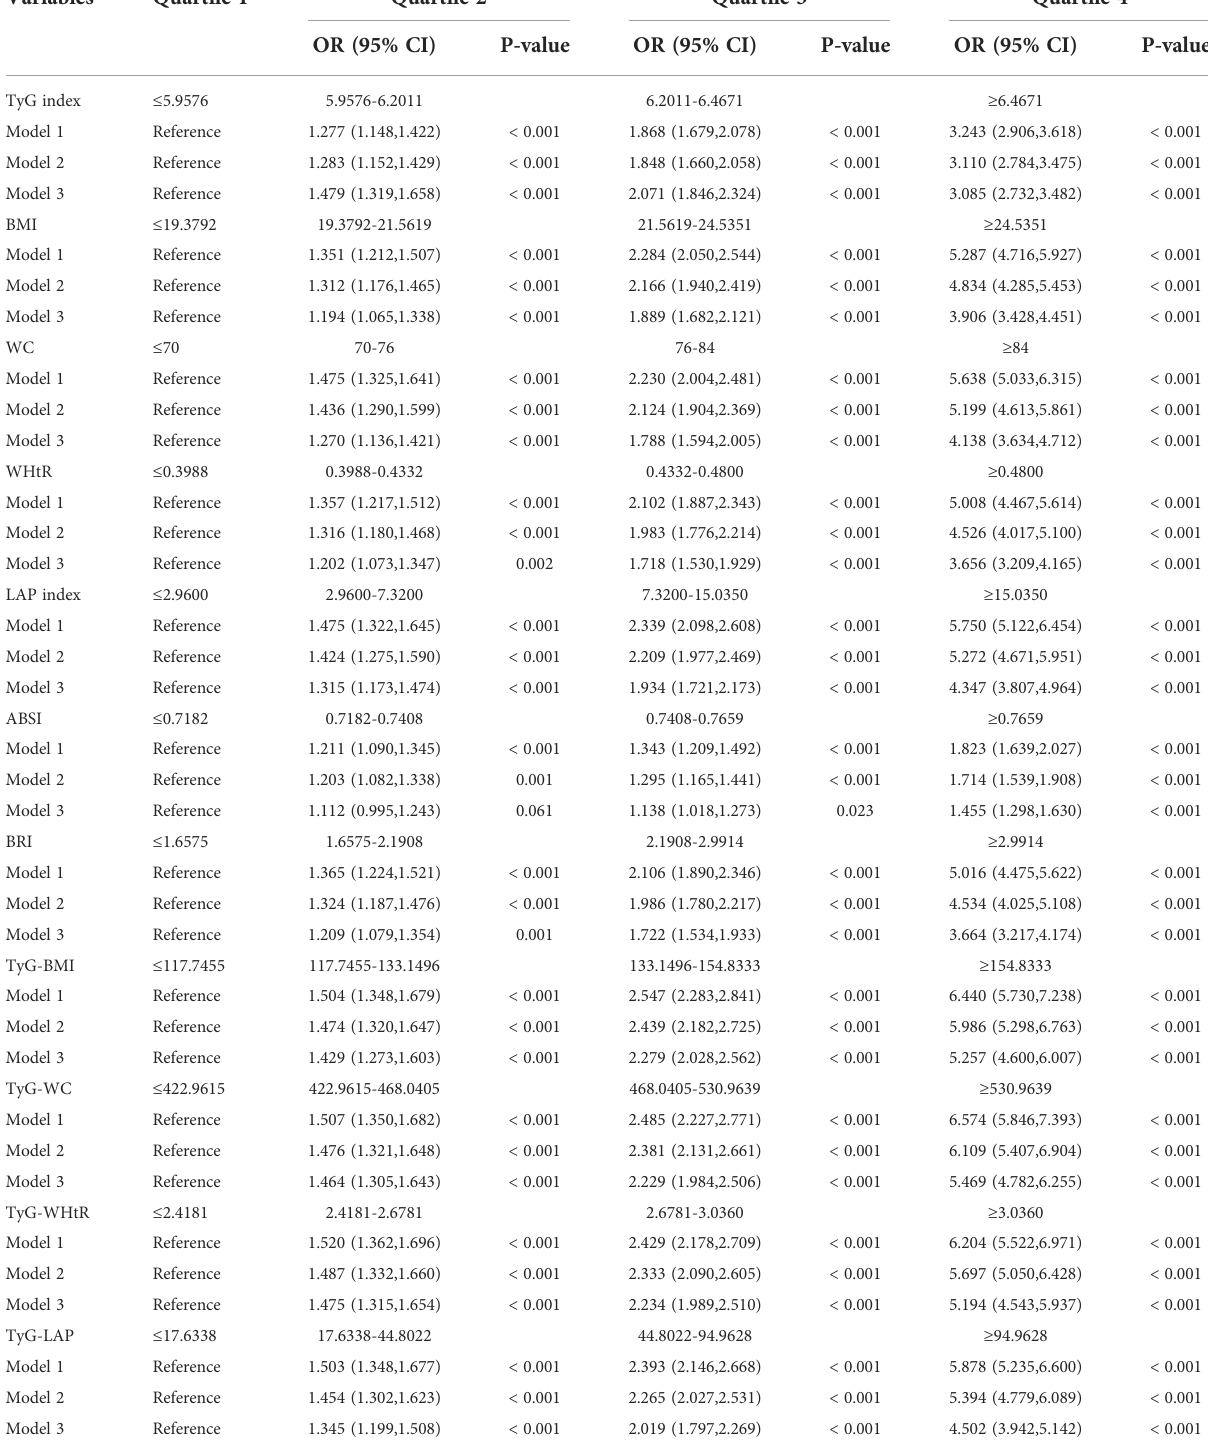
TABLE 2 Multivariate logistic regression of different indices for HUA